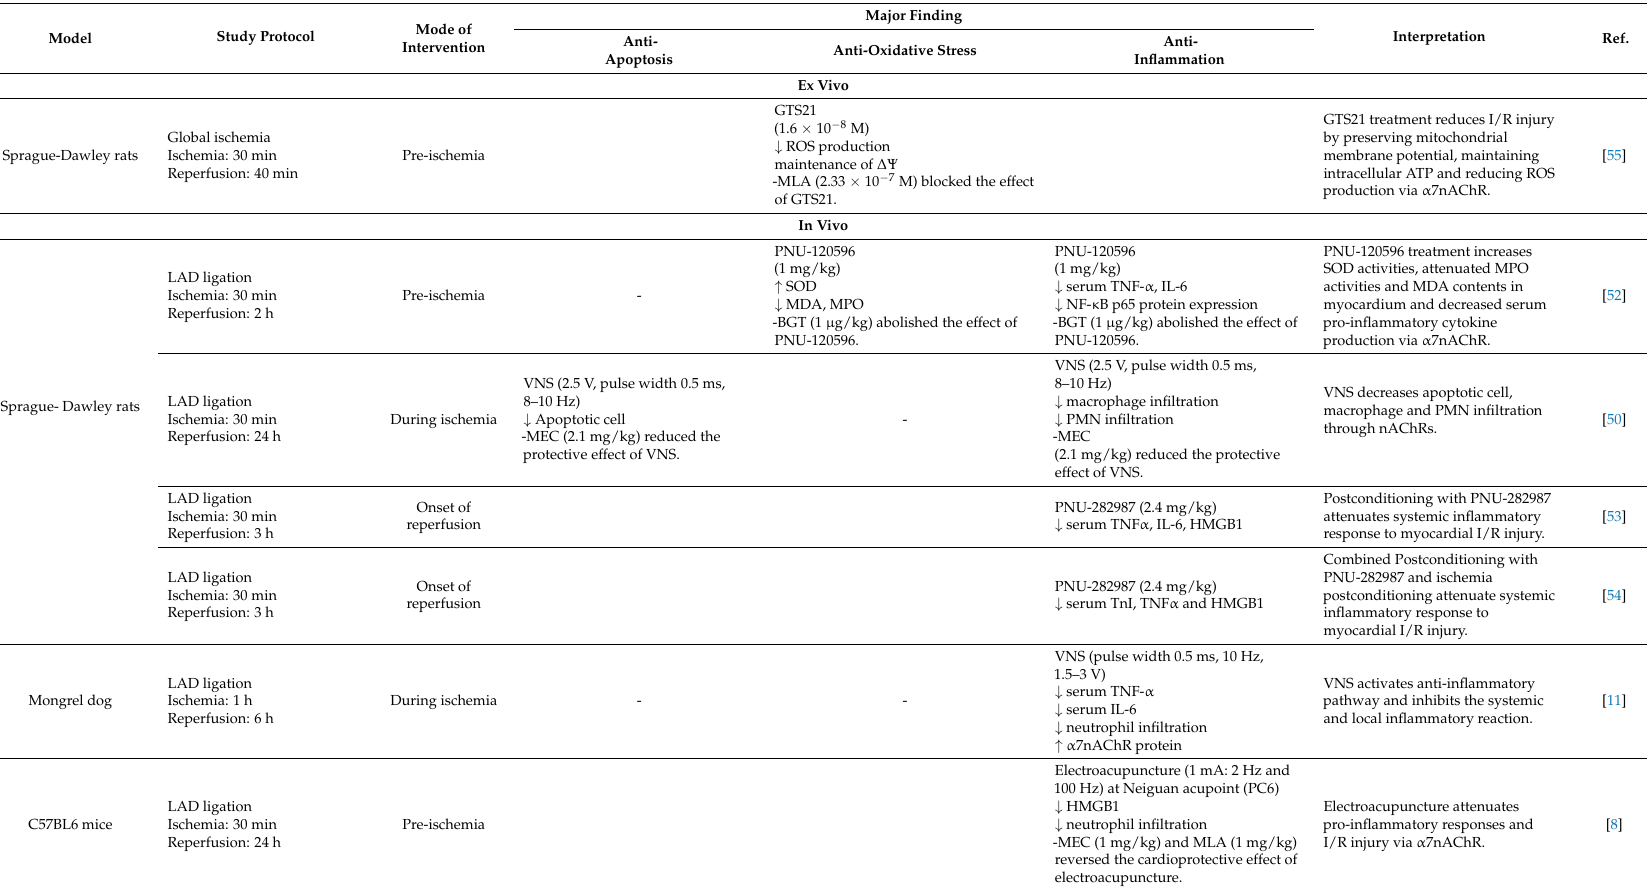
Table 4. Anti-apoptosis, anti-oxidative stress and anti-inflammation through nicotinic acetylcholine receptor activation against ischemia/reperfusion